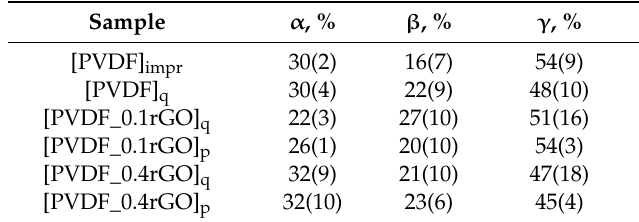
Figure 7. Fourier transform infrared spectroscopy (FTIR) spectra of ( a ) [PVDF] impr , ( b ) [PVDF] q , ( c ) [PVDF_0.1rGO] q , ( d ) [PVDF_0.1rGO] p , ( e ) [PVDF_0.4rGO] q , and ( f ) [PVDF_0.4rGO] p . Table 3. Relative fraction of the α , β , and γ -phases estimated using FTIR spectra.